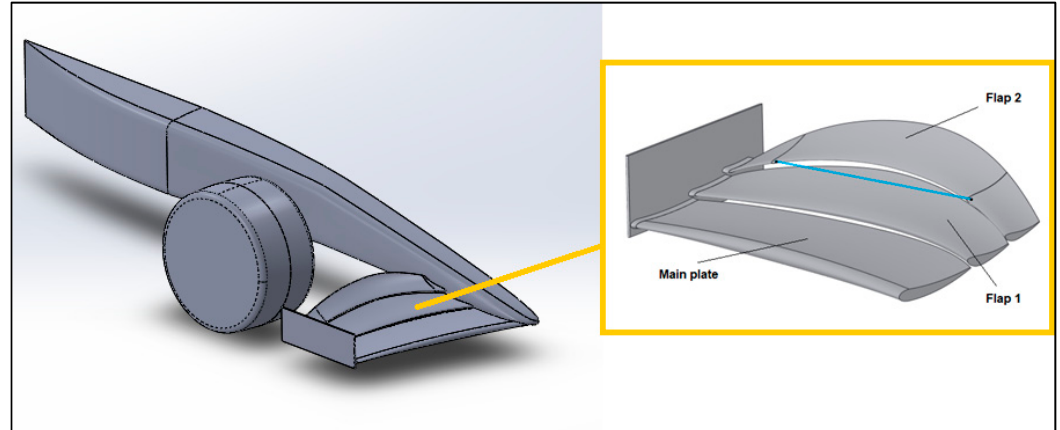
Figure 1. Geometry of the model and front wing details (blue line representing axis of rotation).